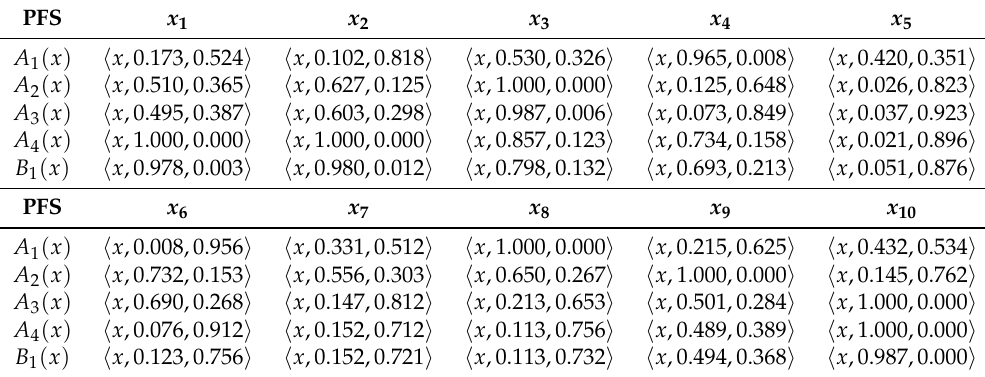
Table 3. The Pythagorean fuzzy sets of building materials in Example 3.